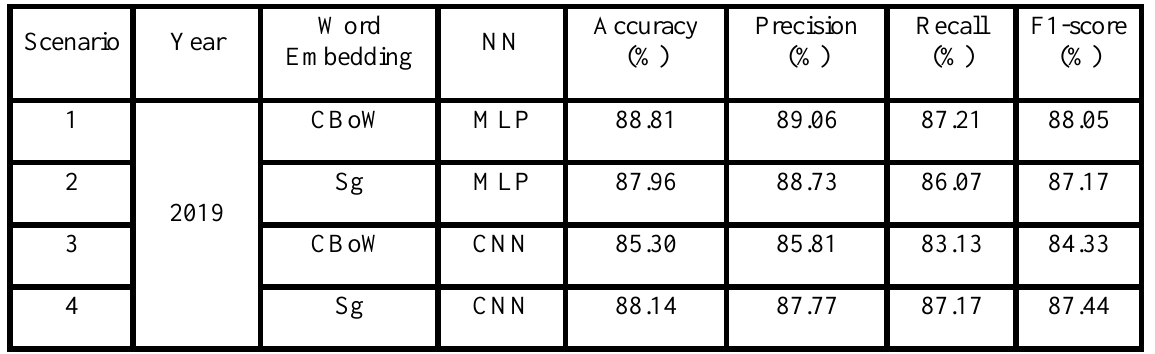
Table 2 Scenarios evaluation results